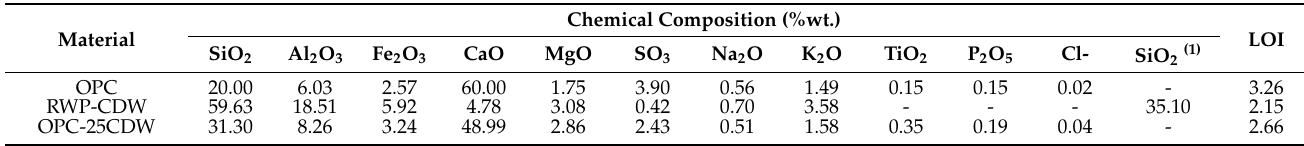
Table 1. Chemical composition of RWP-CDW and OPC-25CDW XRF analysis.